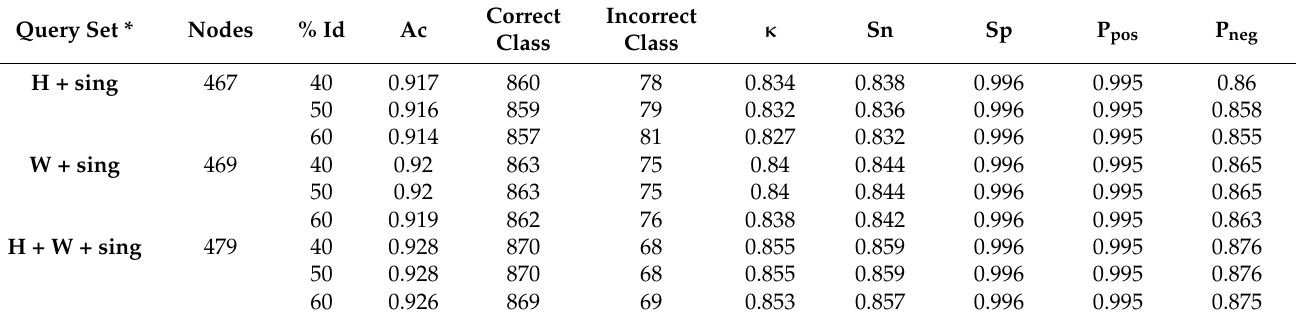
Table 3. Statistical analysis for the performance of the best 9 SSMs on the target Small dataset.